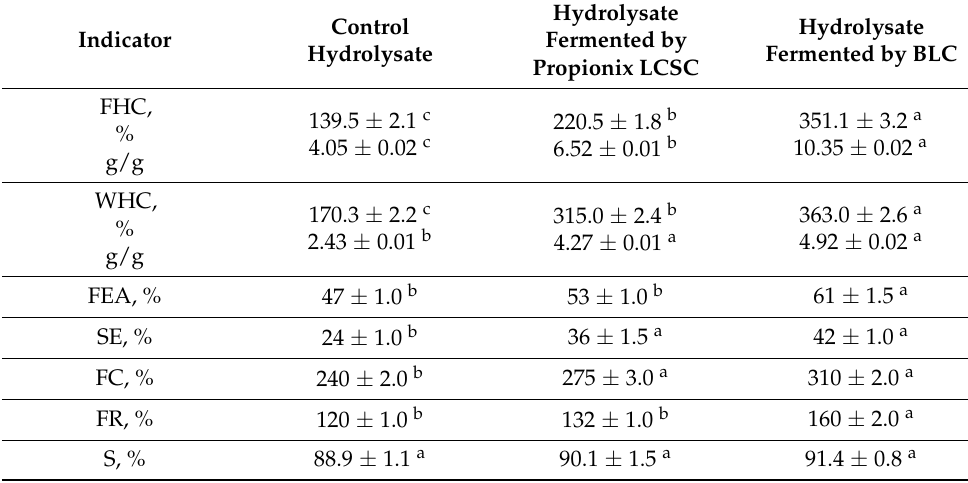
Table 2. Technological indicators of protein hydrolysates.